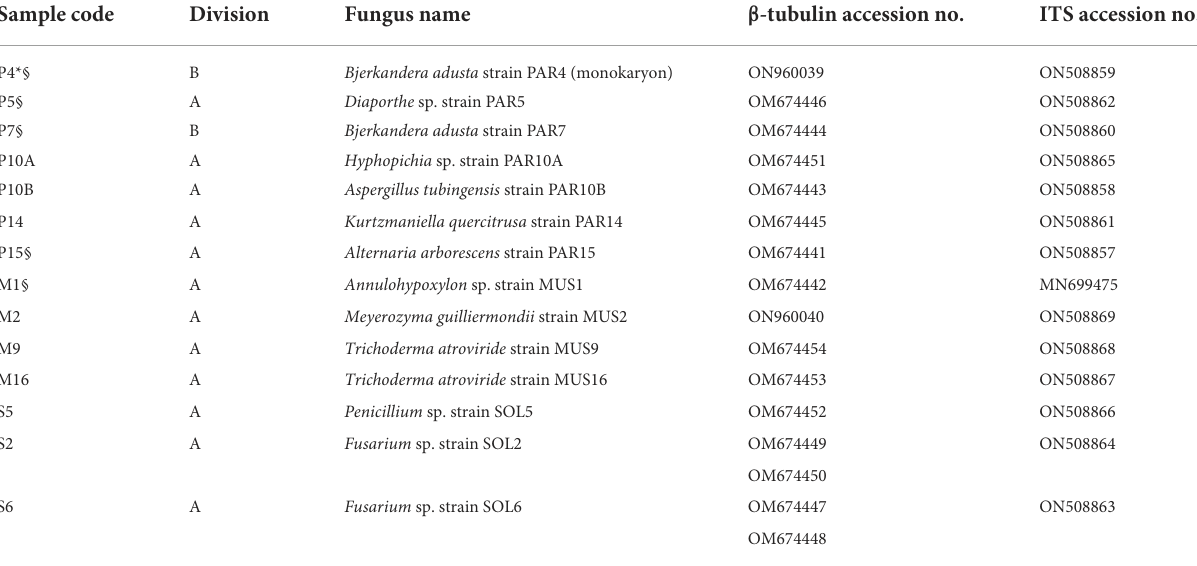
TABLE 1 Fungi isolated from the Himalayan Yew ( Taxus wallichiana Zucc .) and used in this